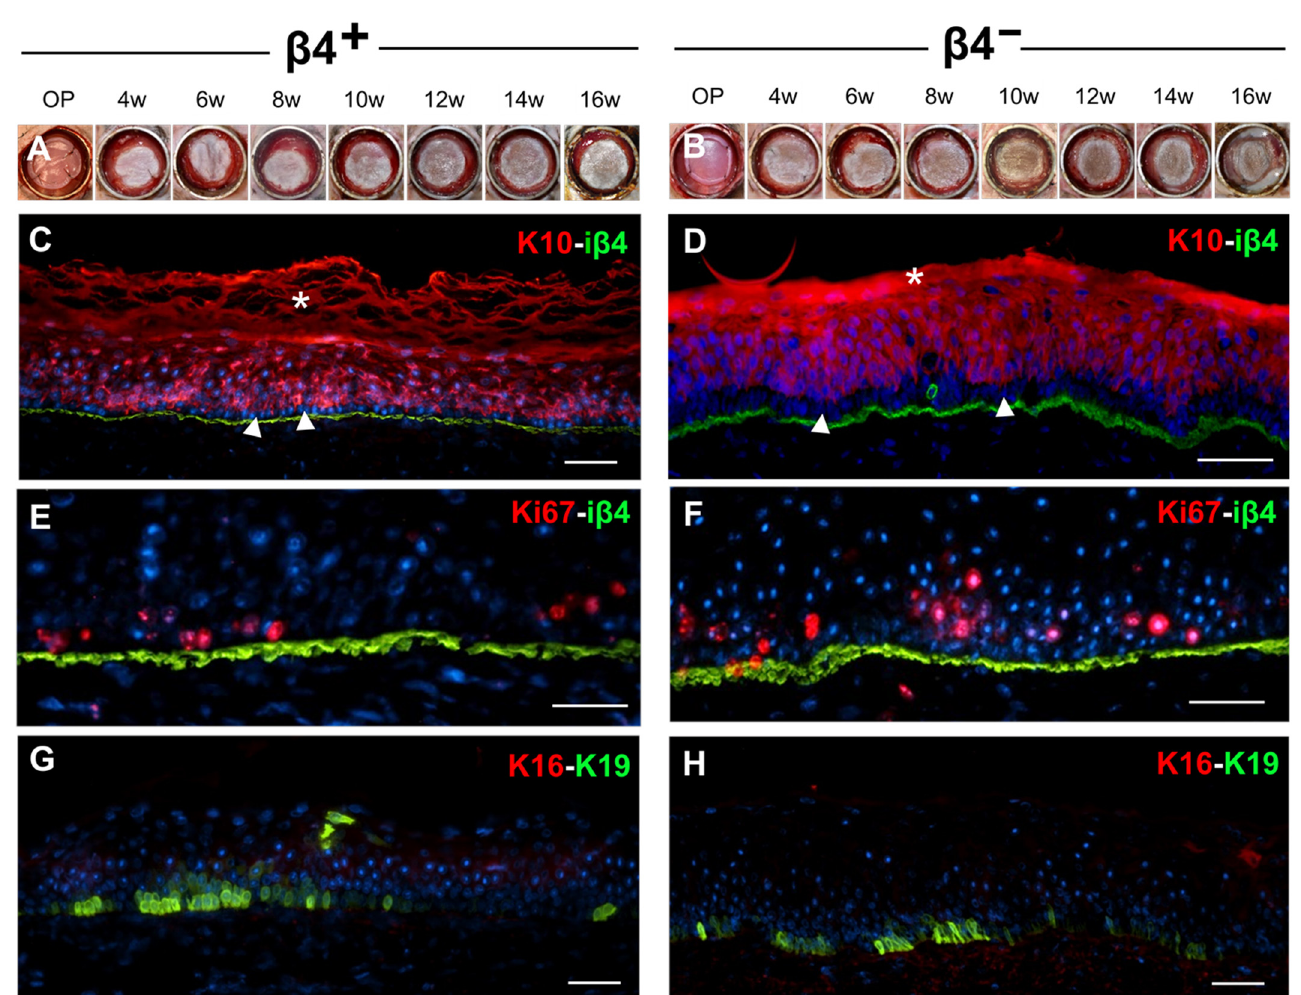
Figure 6. Basal and suprabasal keratinocytes show equal regeneration potential in vivo. Freshly isolated and sorted i β 4 + and i β 4 − keratinocytes were separately included in dermo–epidermal skin substitutes and transplanted on nude immuno-incompetent rats. ( A , B ) Macroscopic view of the i β 4 + ( A ) and i β 4 − ( B ) transplants, respectively, during 16 weeks in vivo. Thereafter the grafts were sectioned and analysed by immunofluorescence staining for ( C , D ) human basement membrane i β 4 (green) and suprabasal differentiation marker human K10 (red, * denotes unspecific staining in the cornified layer), ( E , F ) i β 4 (green) and proliferation marker Ki67 (red), ( G , H ) human basal K19 and would healing marker K16 (red). White stars: unspecific staining in the stratum corneum. Scale bar: 50 µ